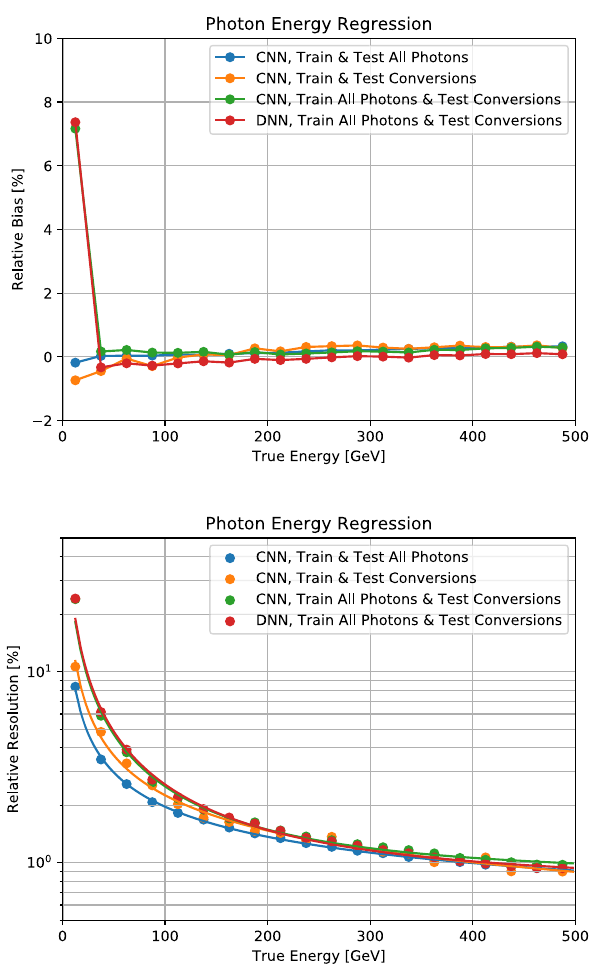
Fig. 39 Bias (top) and resolution (bottom) as a function of true energy, for photons using CNN or DNN regression. We look at the photon sample when split up by conversions